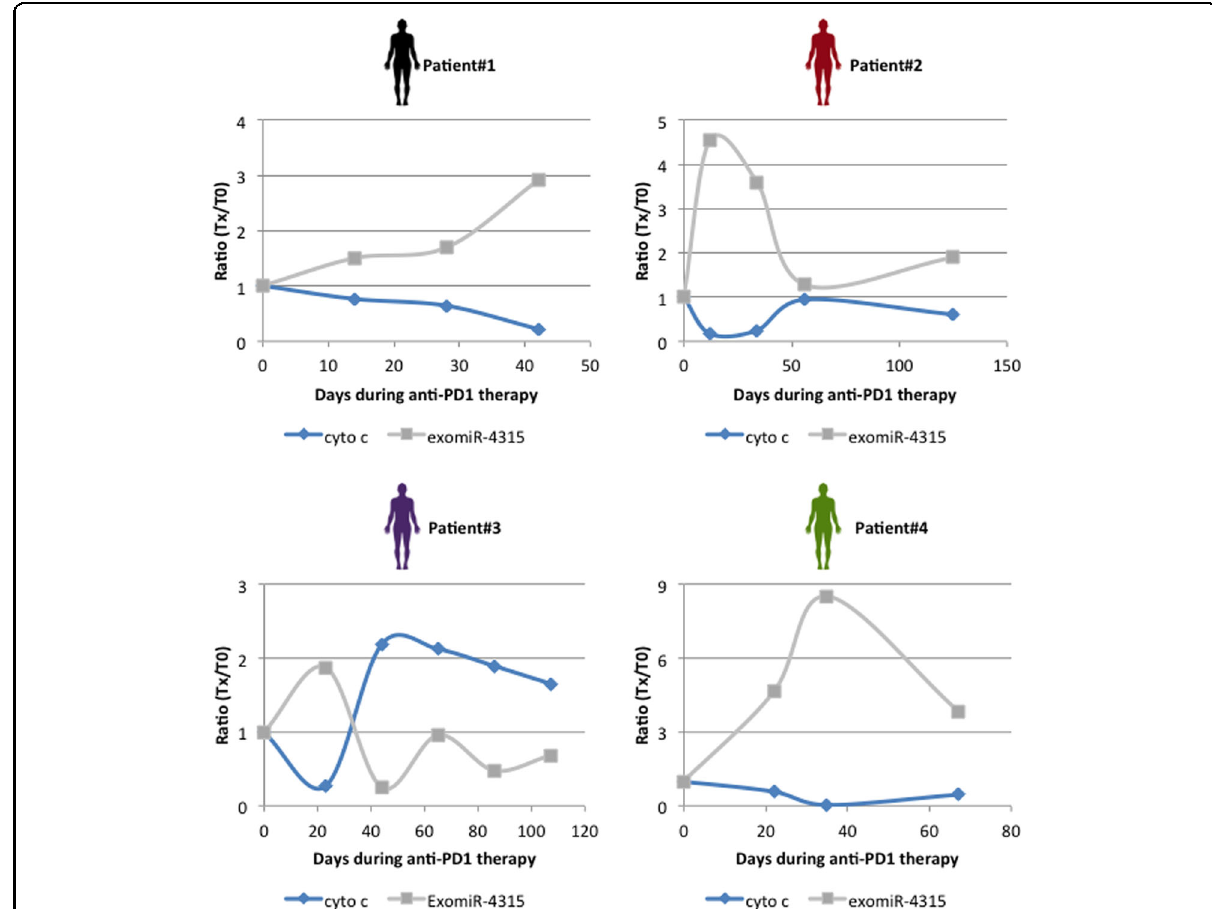
Fig. 4 The longitudinal expression of exomiR-4315 is associated with a serum biomarker of apopto-resistance in lung cancer patients treated with anti-PD1 therapy. Graphs illustrate the longitudinal evolution of exomiR-4315 expression and blood cytochrome c in four lung cancer patients treated with anti-PD1 therapy (one patient per graph) (Expressed as a ratio at measurement day compared to